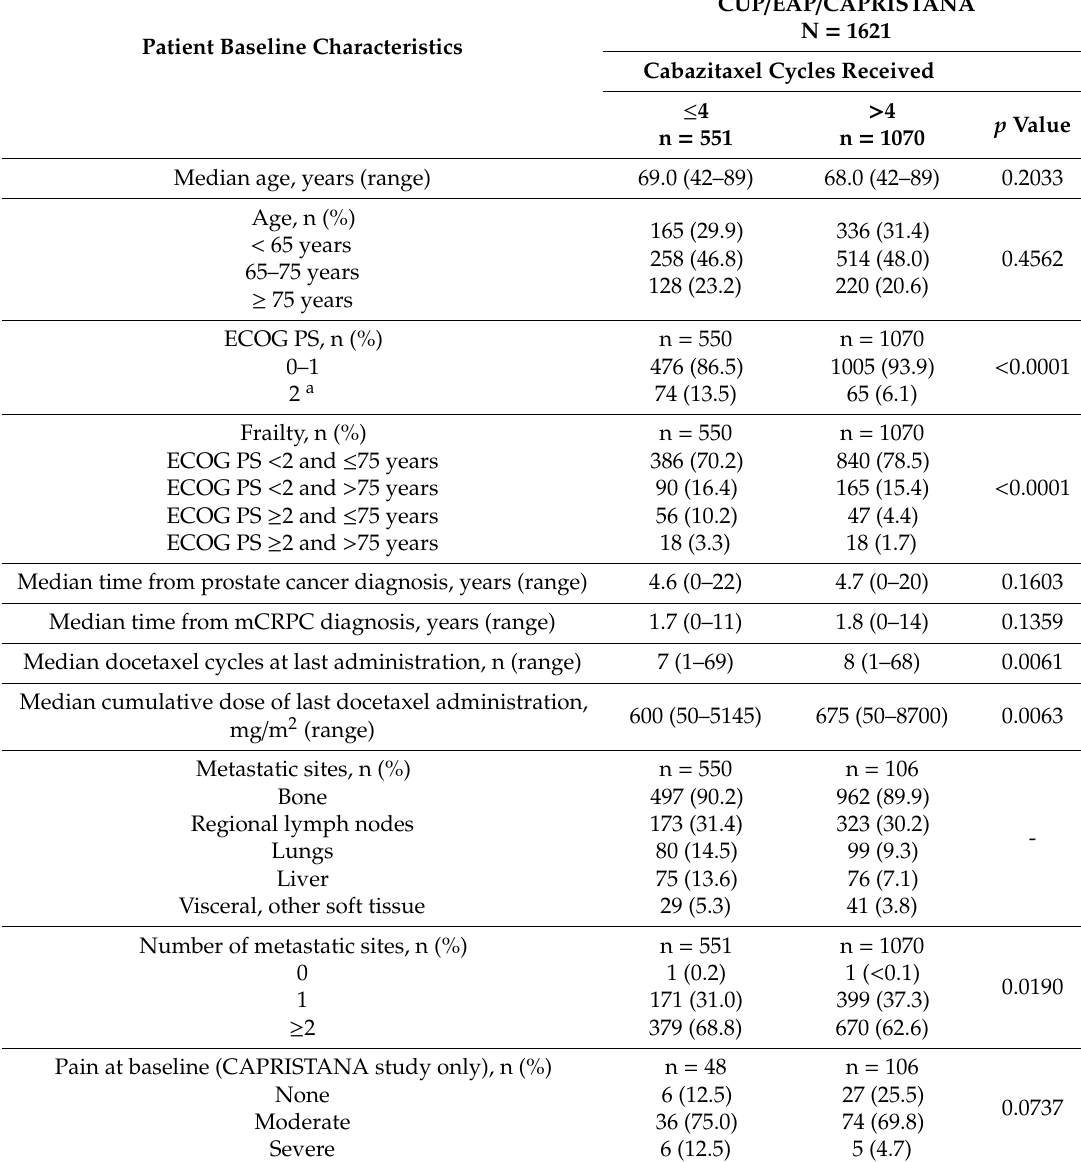
Table 3. Patient baseline characteristics according to the number of cabazitaxel treatment cycles received ( ≤ 4 vs. > 4 cycles) across the CUP / EAP and CAPRISTANA